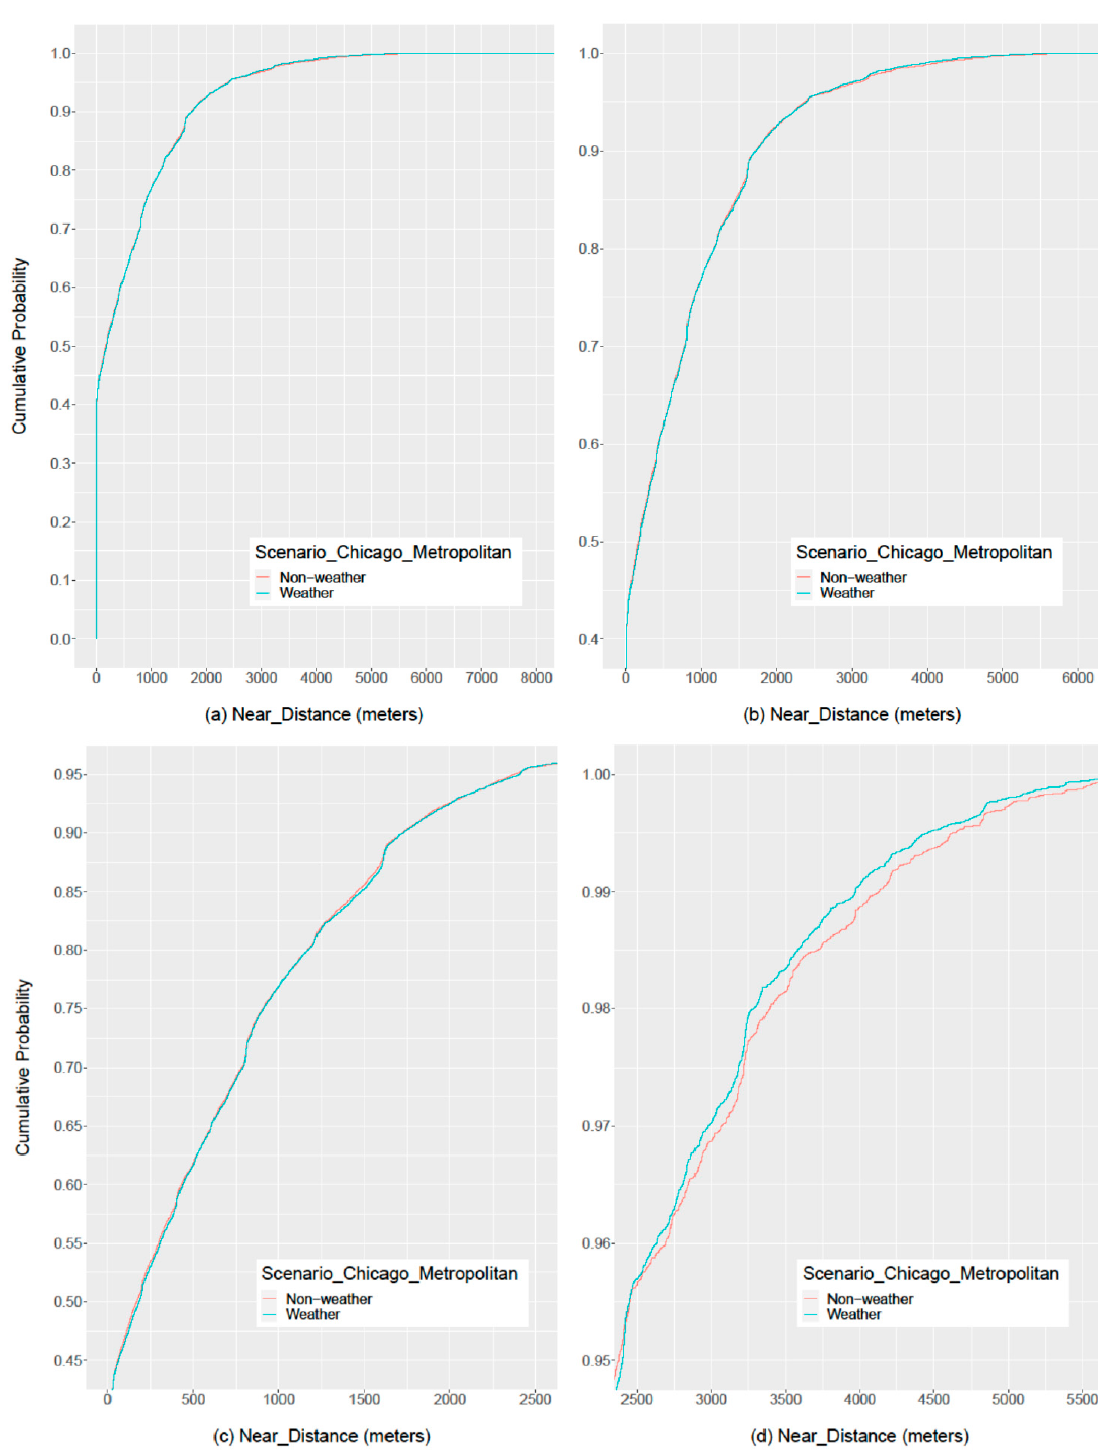
Figure 3. Nearest distance to adjacent highways for Chicago metropolitan. ( a ) Overall display; ( b ) zoom-in display 1; ( c ) zoom-in display 2; ( d ) zoom-in display 3.